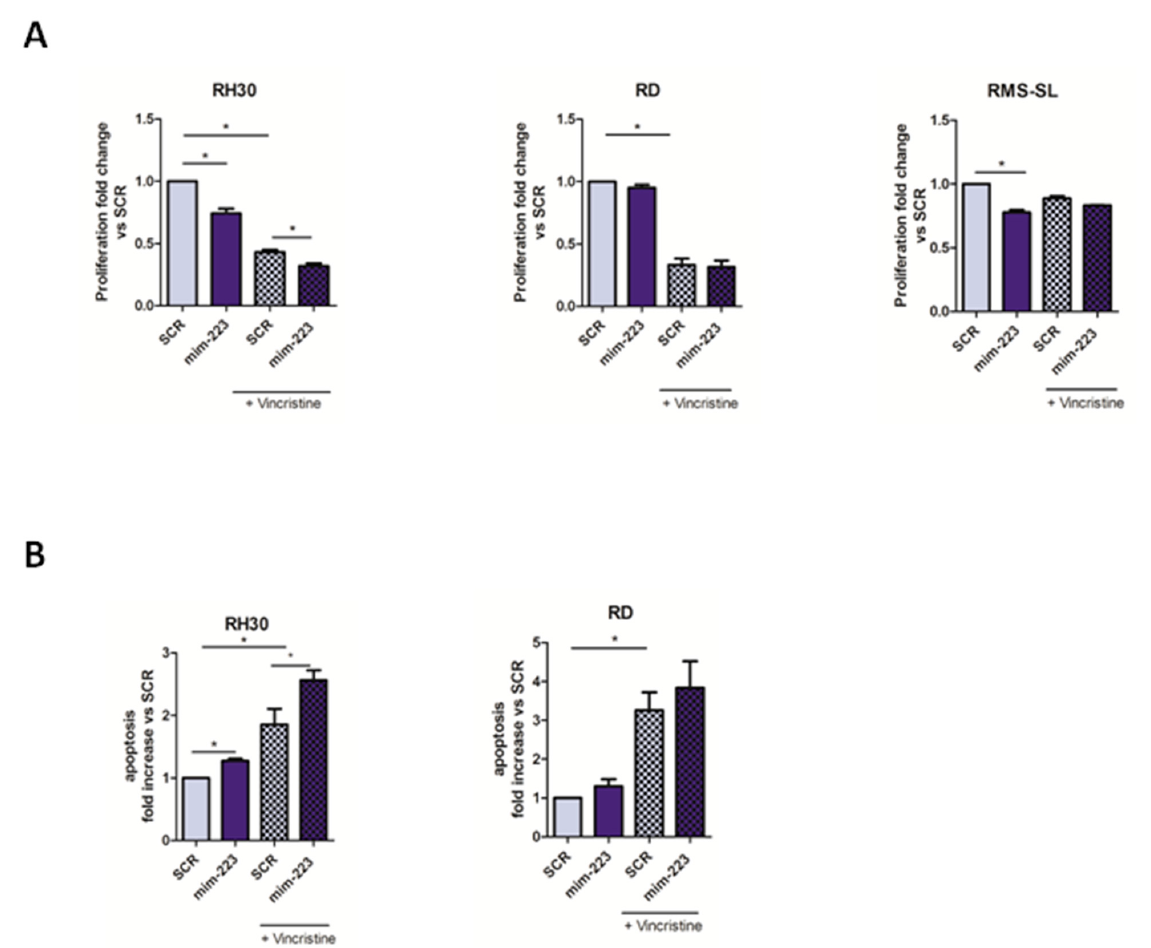
Figure 4. Combination of miR-223 replacement and Vincristine reduced RMS proliferation. ( A ) MiR- 223 over-expression reduced adolescent RMS-proliferation alone and in combination with Vincristine (1 µ M) compared to controls ( n = 5). ( B ) Analysis of apoptotic cells treated with miR-223 in combina- tion with Vincristine ( n = 3). All data are expressed as mean ± SEM. * p < 0.05 vs. cells transfected with